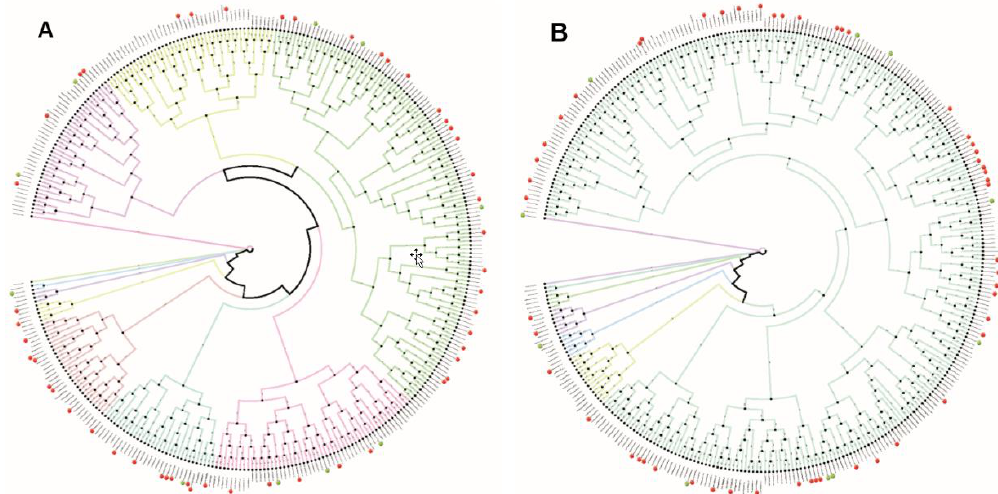
Figure 2. Phylogenetic analysis of the promoter regions shows little variation between the promoters of the corresponding gene sets. A multiple sequence alignment and phylogenetic tree construction was performed on the upstream promoter regions of both the 8-h and the 12-h gene sets with Felsenstein nucleotide substitution model ( A ) and a Jukes-Cantor substitution model ( B ). A control set of 10 non-oscillating genes was added to the phylogenetic analysis (green markers). The red markers represent the position of the 8-h oscillating genes. The 12-h oscillating genes are the unmarked positions. A high-resolution figure is provided as Figure S2.